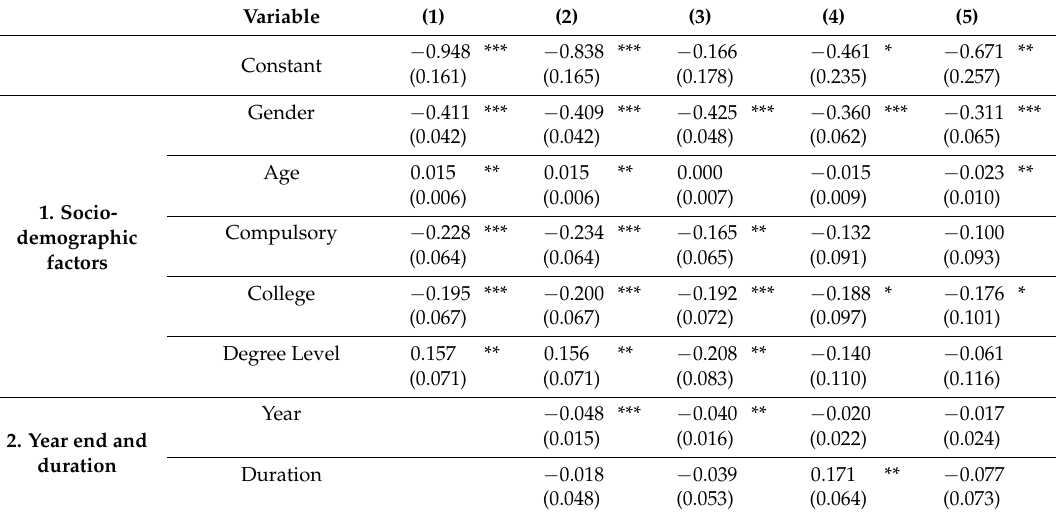
Table 3. Probit model